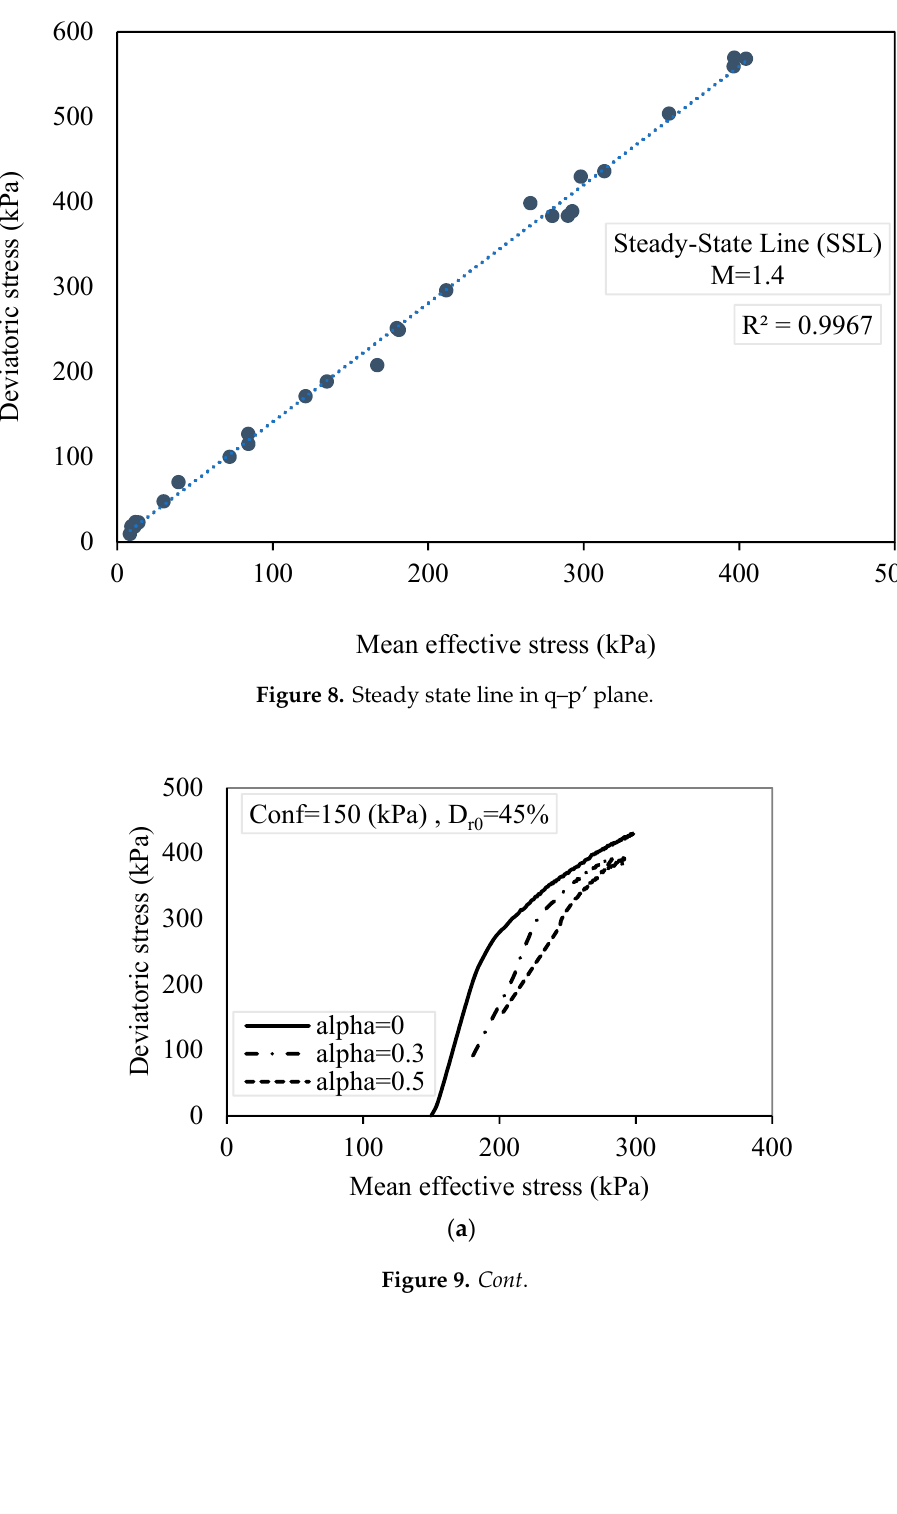
Figure 8. Steady state line in q–p’ plane.